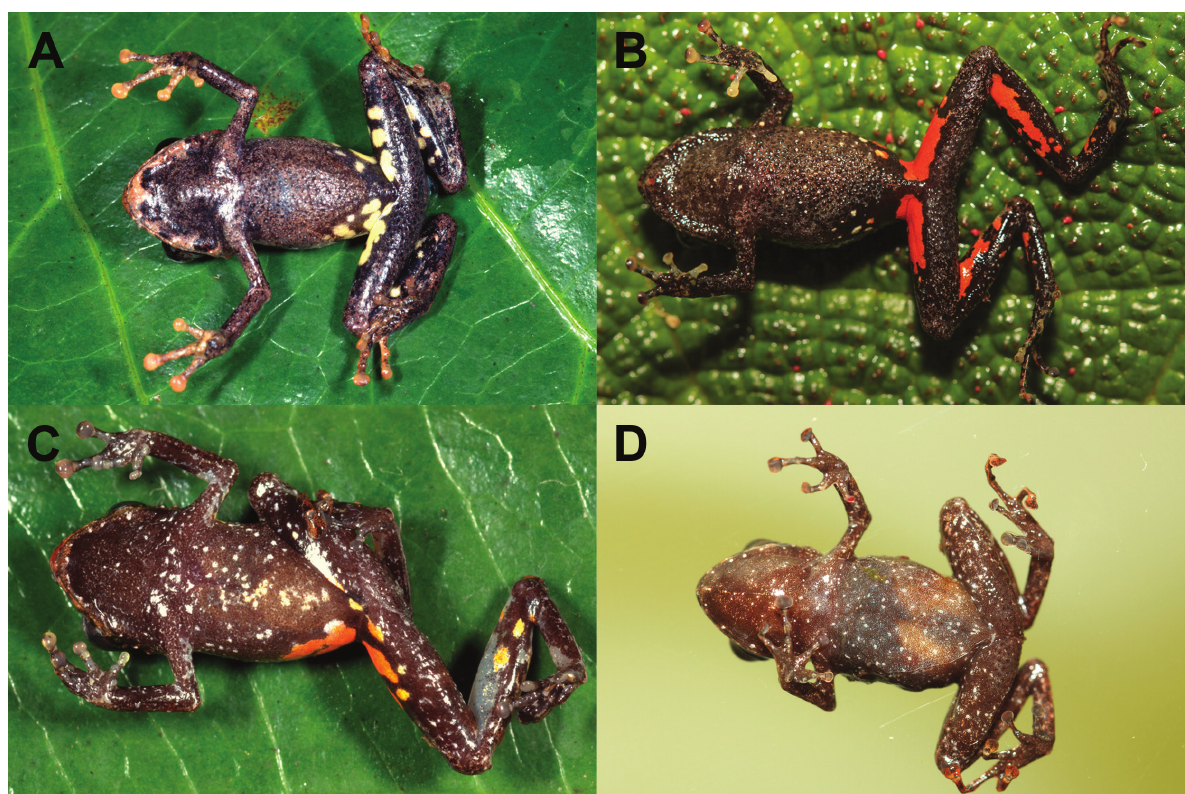
Figure 4. Ventral view in life of Pristimantis cruciocularis group’s species: ( A ) P. antisuyu (CORBIDI 18726); ( B ) P. cruciocularis (CORBIDI 11554); ( C ) P. erythroinguinis (MUSM 30468); ( D ) P. sira sp. nov. (CORBIDI 14430). Photographs by Alessandro Catenazzi ( A, C ) and Germán Chávez ( B, D